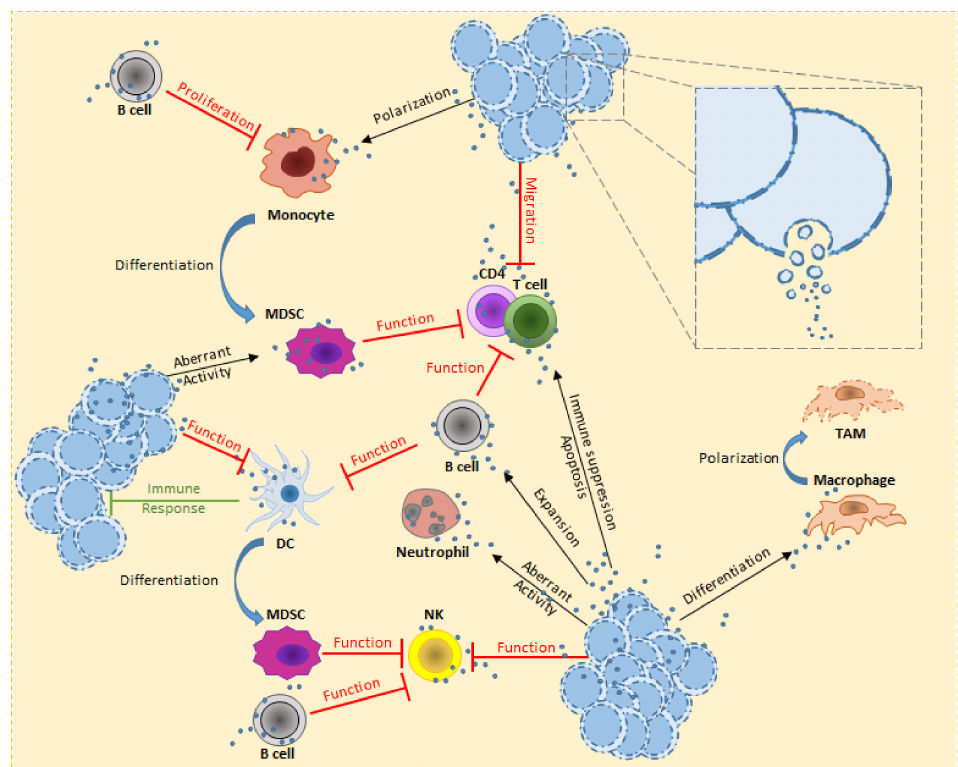
Figure 1. Overview of hematological malignancy-derived small EV e ff ects on immune cells. In order to escape from the immune system, tumor cells deploy several strategies. TEVs are used to stimulate B cell expansion and activity against several immune cells (e.g., T cells and NK). T cells are known to be a ff ected on the proliferative potential and cytokine production. TEVs directly reduce the T cells migration, leading to up-regulation of receptors involved in immune suppression and or activate pro-apoptotic signals. Alternatively, MDSCs acquire strong immune suppression activity, either from interaction of TEVs or aberrant di ff erentiation from myeloid cells (e.g., monocytes) or immature DCs. Under the e ff ect of TEVs, monocytes polarize towards a pro-tumorigenic form. This leads to pro-inflammatory cytokines release and expression of receptors involved in immune suppression. NK cells have high cytotoxic activity, the tumor uses TEVs to heavily decrease this threat. Furthermore, accumulation of pro-tumorigenic MDSCs also increases this inhibitory e ff ect. TEVs have been reported to stimulate macrophage polarization towards M2 form, this ensure the TME with an increasing pool of TAM which release pro-tumorigenic growth factors, chemokines and cytokines. The